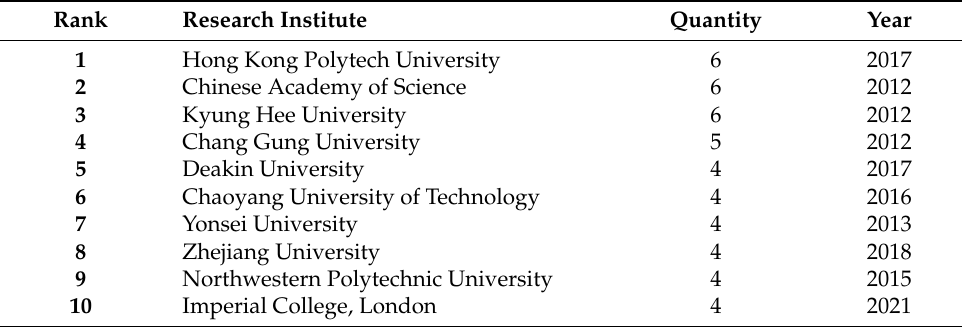
Figure 5. The institutions’ networks of studies from CNKI. (The contents in brackets are the transla- tions of the original results which are presented in Chinese). Table 7. Top 10 institutions for publications from Table 6. The institution networks of studies from CNKI.